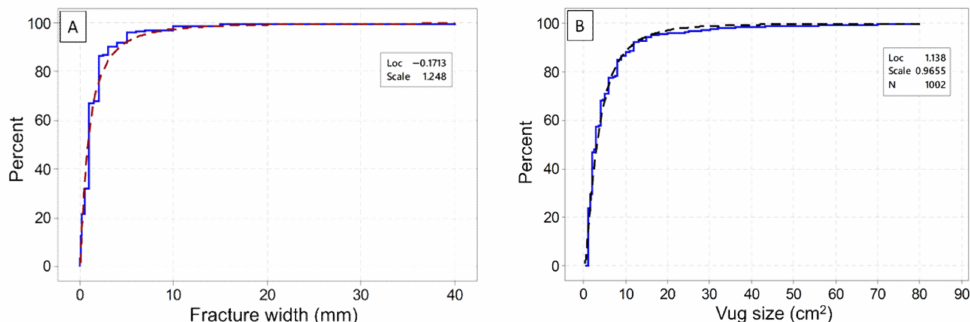
Figure 9. Cumulative frequency distributions of fractures ( A ) and vugs ( B ) based on NMQP of 185 core boxes. Blue lines represent width data collected on core. Dashed lines represent log-normal distributions of